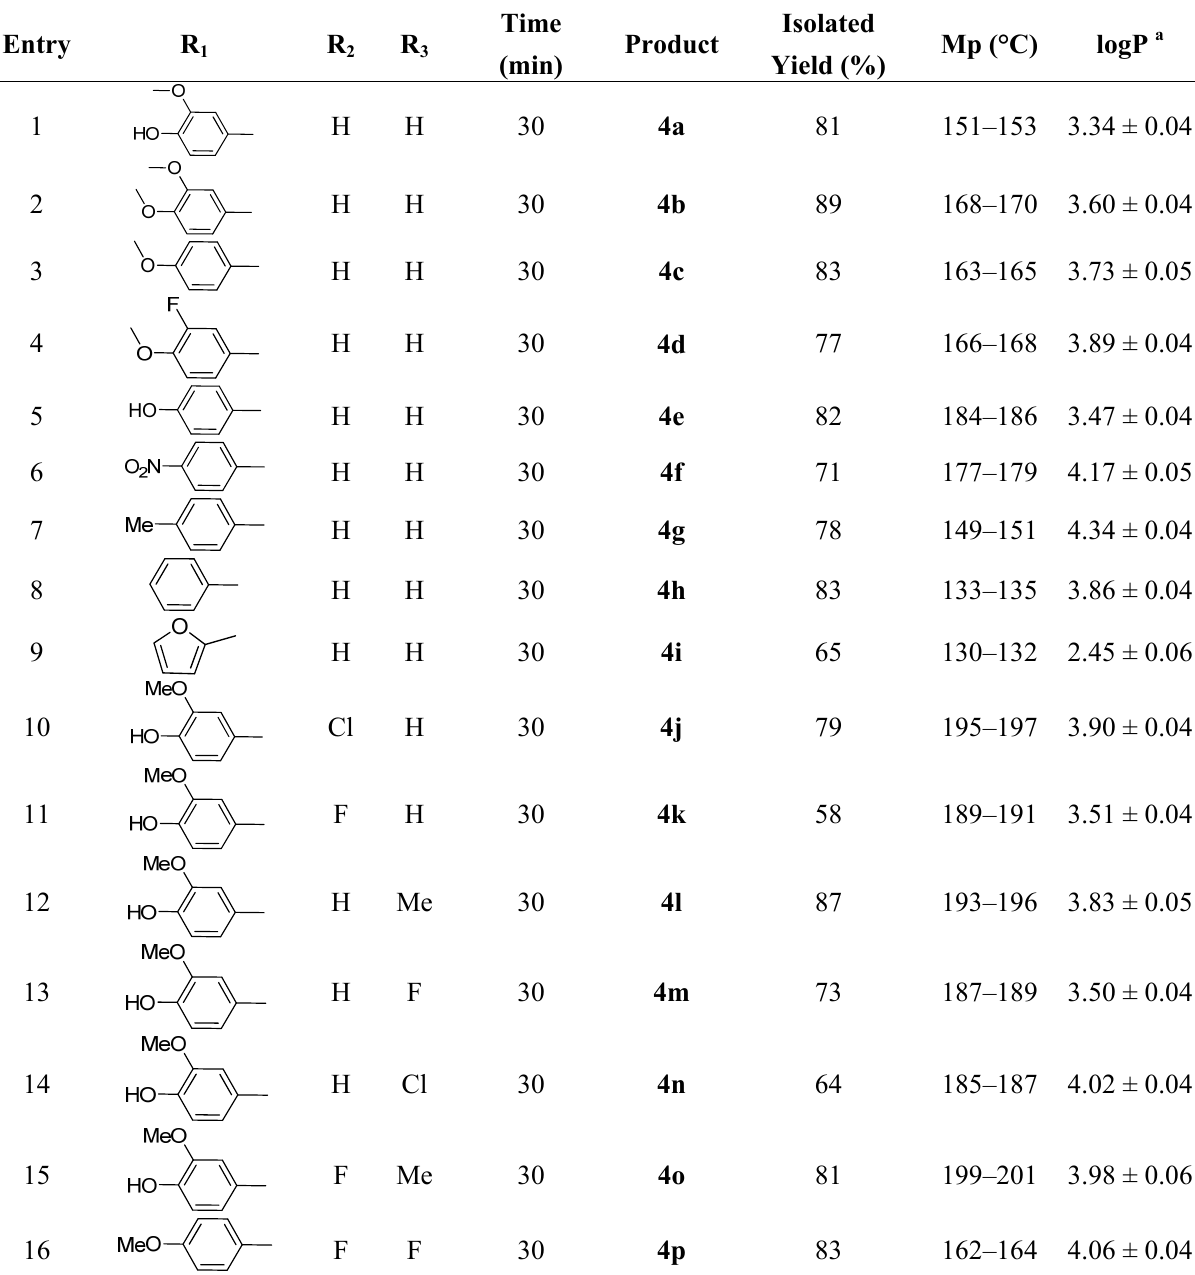
Table 3. Synthesis of 3-substituted-chroman-2,4-diones( 4a – p ) via Scheme